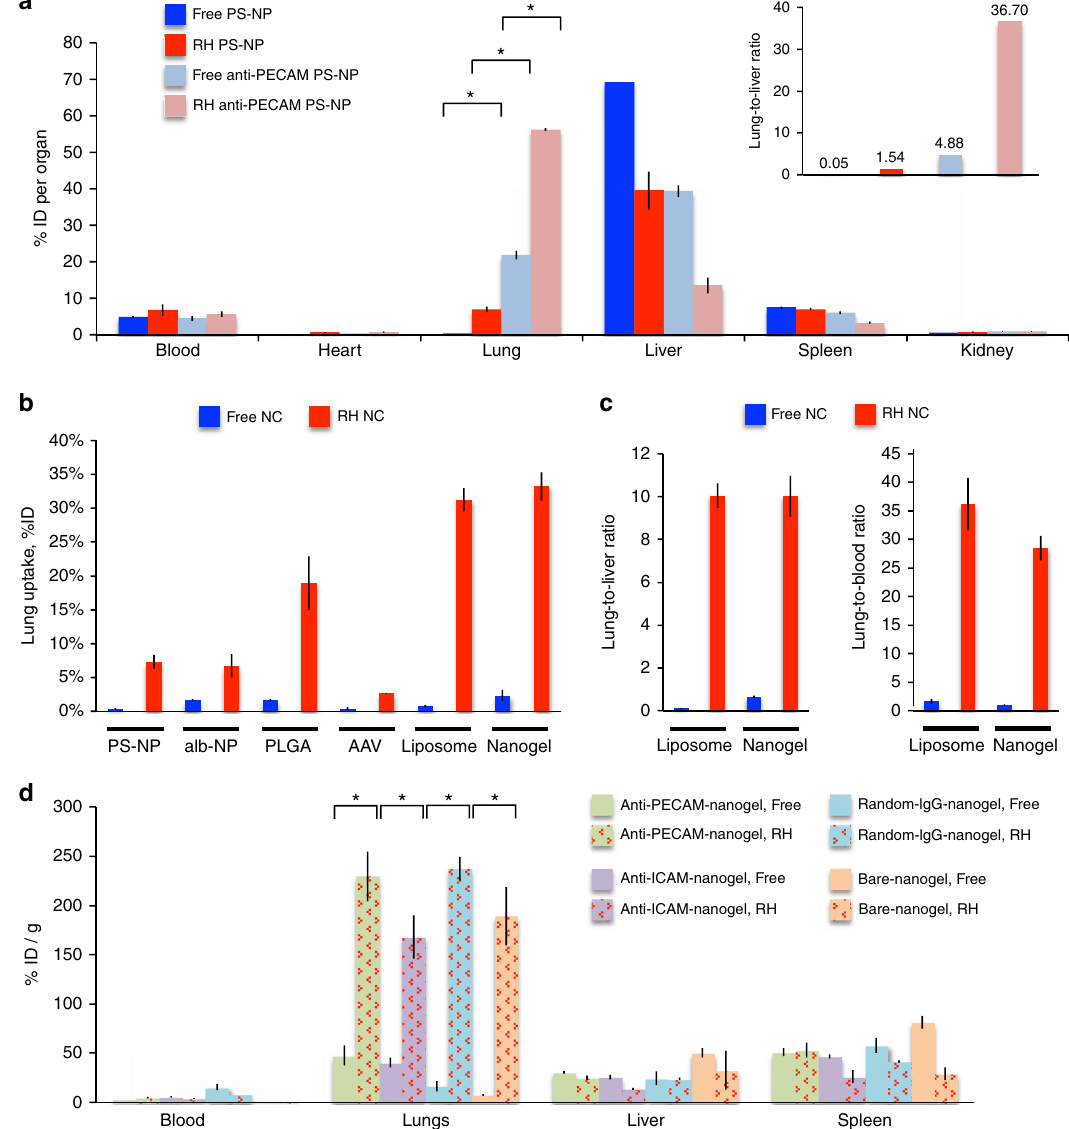
Fig. 2 IV injection of optimized RH NCs massively augments lung delivery without af fi nity moieties. a Mice were injected IV with polysytrene nanoparticles (PS-NPs) that were covalently coated with either IgG (dark blue) or anti-PECAM antibodies (light blue) and radiolabeled with a trace amount of I-125-IgG. Separate mice were injected with one of those two PS-NPs adsorbed onto RBCs (dark and light red, respectively). Mice were sacri fi ced 30 min later and I- 125 activity in the organs was measured in a gamma counter. Displayed is the percent injected I-125 dose (%ID) for each organ. Inset: lung-to-liver ratios, which are calculated by dividing the lung ’ s %ID per gram of tissue (%ID/g) by the liver ’ s %ID/g. b %ID in the lung of different NCs labeled and injected as in a . c Lung-to-liver (left panel) and lung-to-blood (right panel) ratios of liposomes and nanogels, the two top performing lung-directed RH NCs. d Mice were injected with nanogels that were either uncoated (bare) or covalently coated with one of the three different antibodies (random rat IgG, anti-PECAM, or anti-ICAM) (blue bars). Other mice were injected with each of those four antibody – nanogel formulations adsorbed onto RBCs (red bars). Data are plotted as %ID per organ. Each data point represents mean ± s.e.m ( n = 3). * P < 0.05, non-paired, two-tailed t